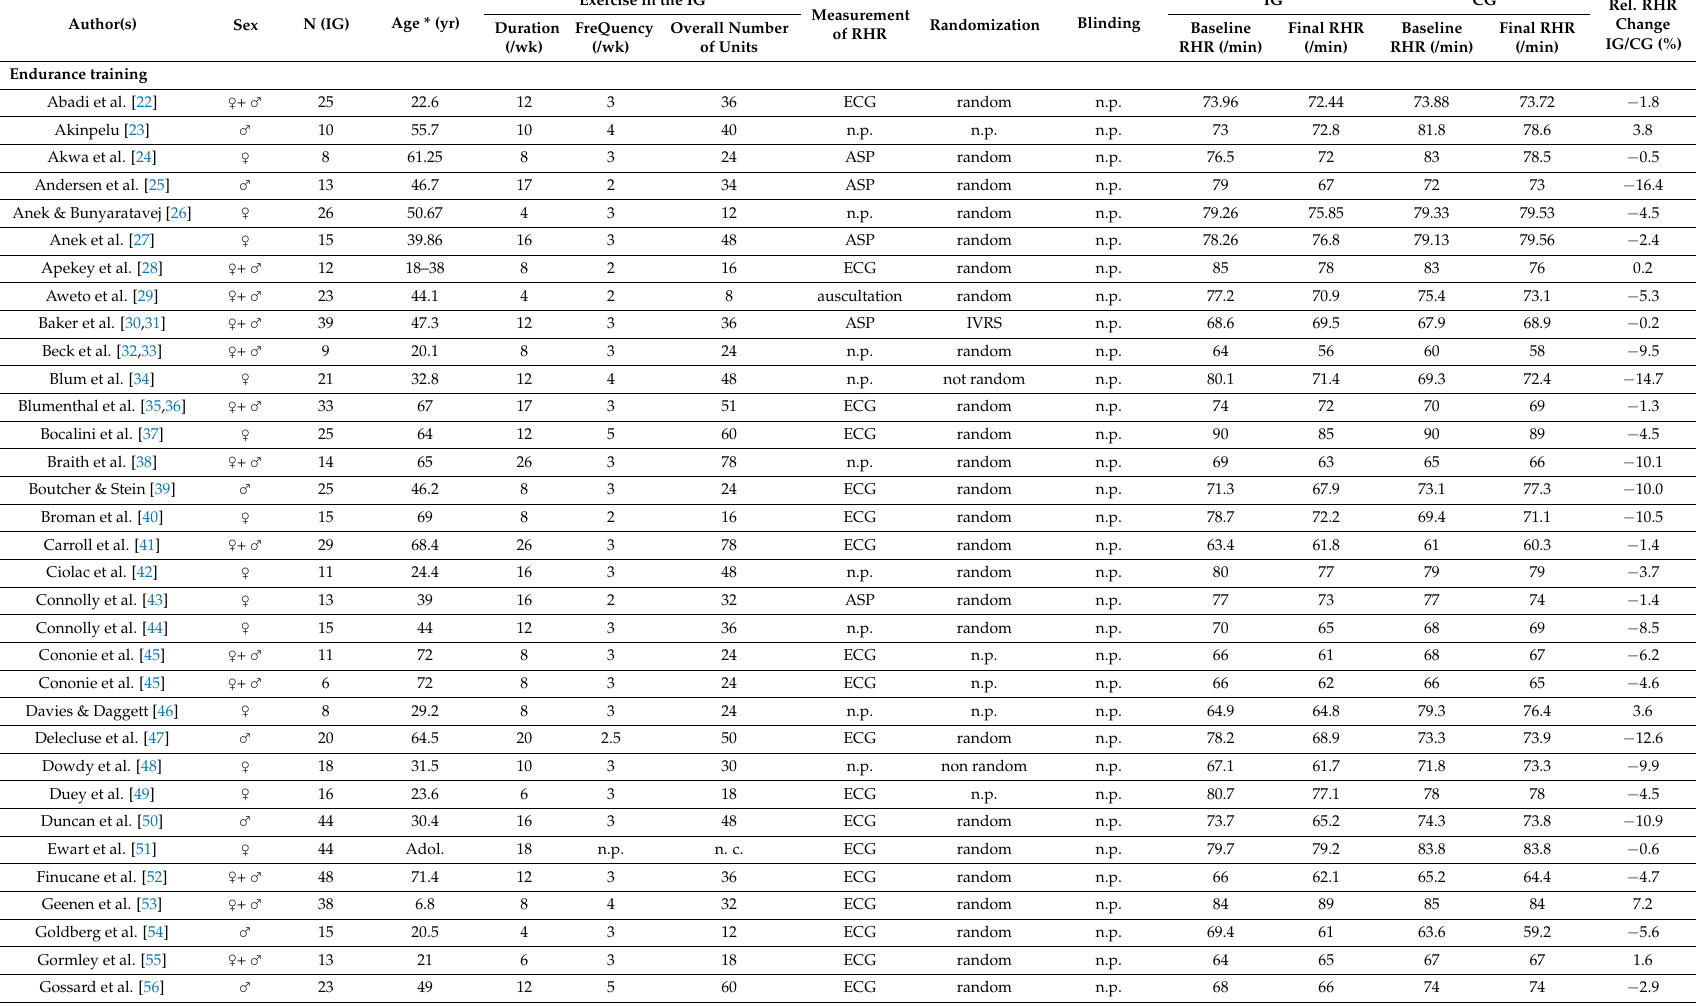
Table 1. Descriptive characteristics of the samples included in the